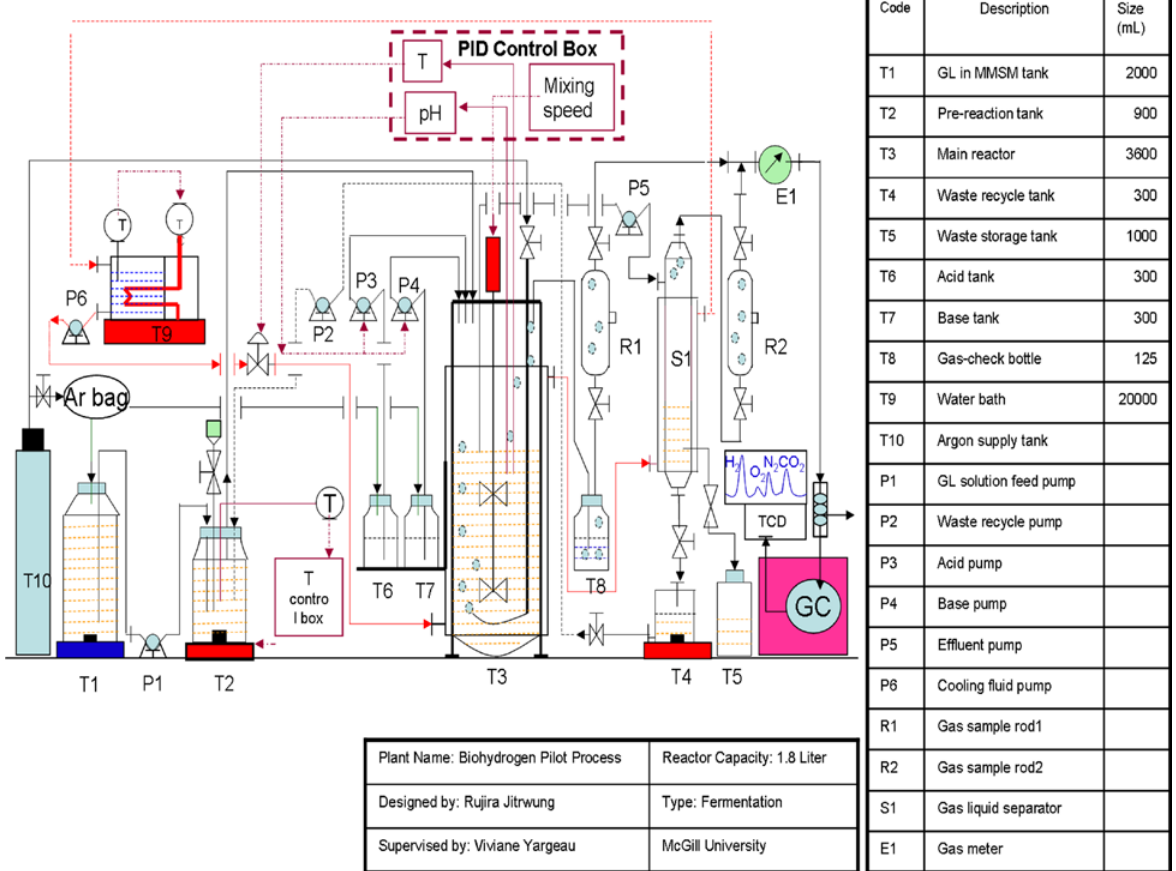
Figure 6. Continuous biohydrogen production